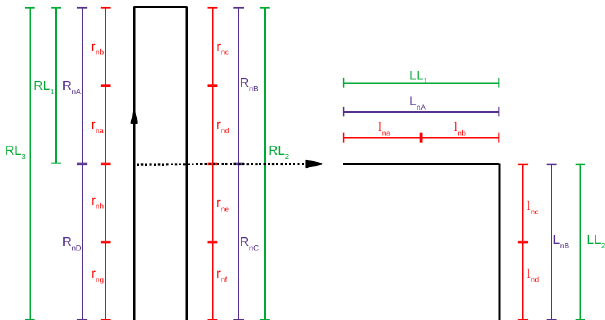
Figure 6. Segmentation of the R and L patterns into straight and sta- bilized segments of equal duration and length for turbulence studies (T-shortlegs: 30km/5min in red, referred to as r nx or l nx , where n is the pattern number; T-longlegs: 60km/10min in purple, referred to as R nX or L nX ). Also reported are the longest stabilized legs in one direction (T-longestlegs, 120km/20min or 60km/10min, in green, referred to as RL i or LL i , where i = 1 ...P , and P is the number of such segments for the flight). A similar nomenclature is used for the segmentation of the S patterns. See Table 2 for the definition and the nomenclature of these segments. After Brilouet et al.